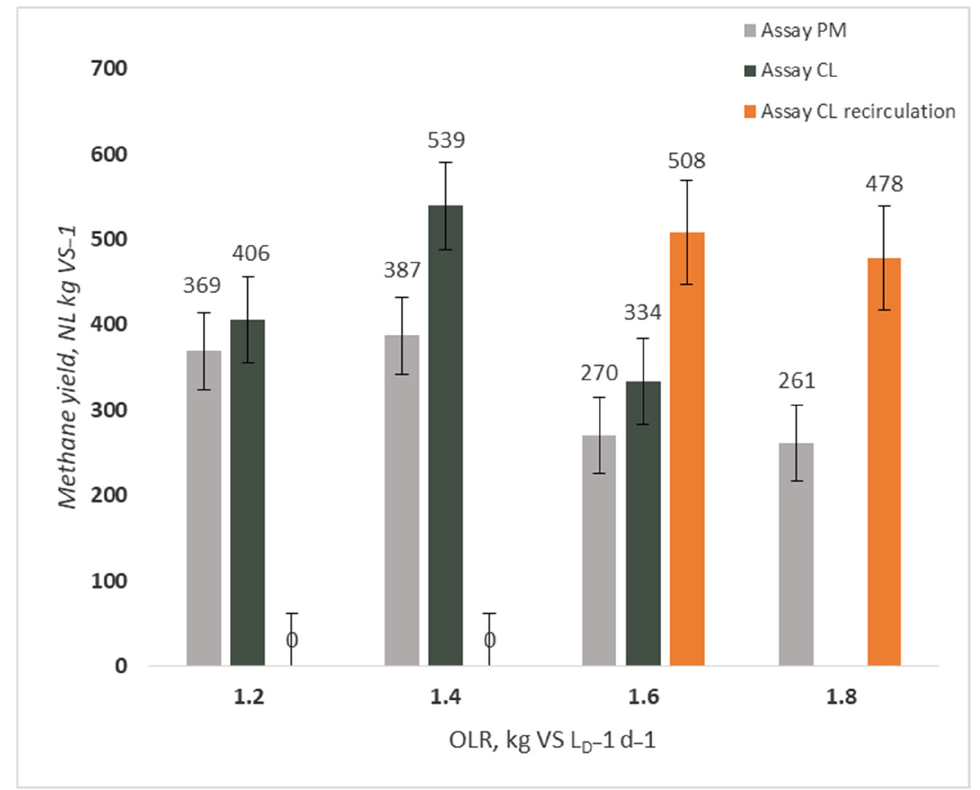
Figure 2. Methane yield values for each studied period at different OLRs.